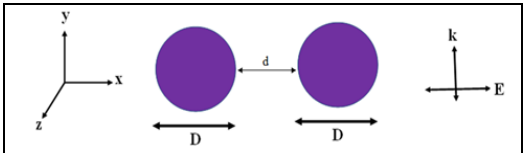
Figure 1: Schematic of a homo-dimer metallic nanosphere. The direction of propagation of EM field incident on the sphere is y-direction and field is polarized along the dimer axis (x-axis).